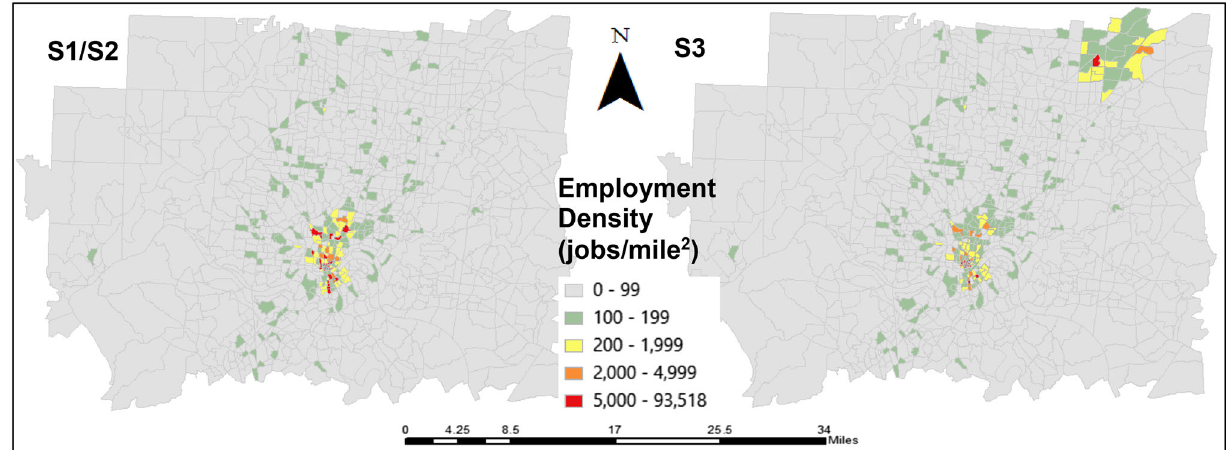
Fig. 6 Projected changes in employment density compare with baseline